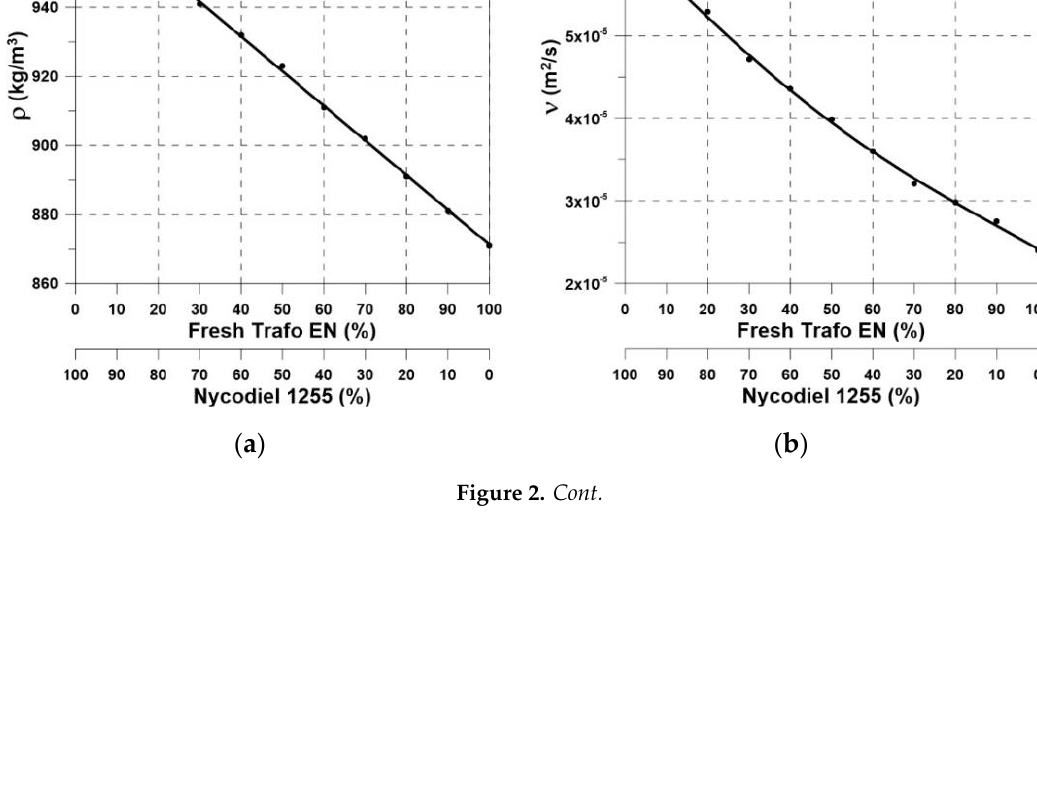
( c ) Figure 2. ( a ) Density, ( b ) kinematic viscosity and ( c ) molecular diffusion coefficient vs. mixing of Nycodiel 1255 synthetic ester with fresh Trafo EN mineral oil.